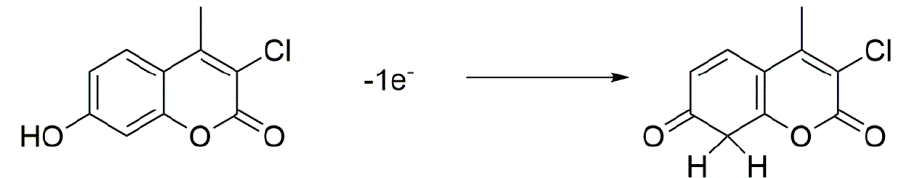
Figure 4. Mechanism of CFN oxidation at GC